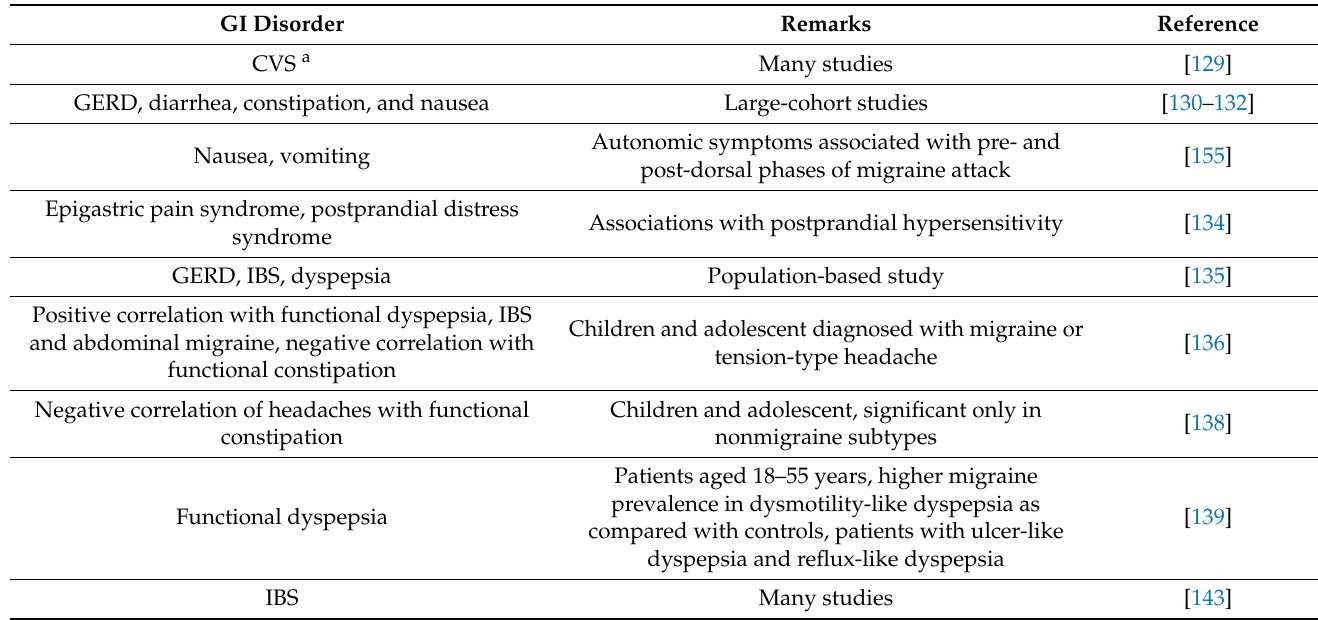
Table 2. Association of migraine with functional gastrointestinal (GI)